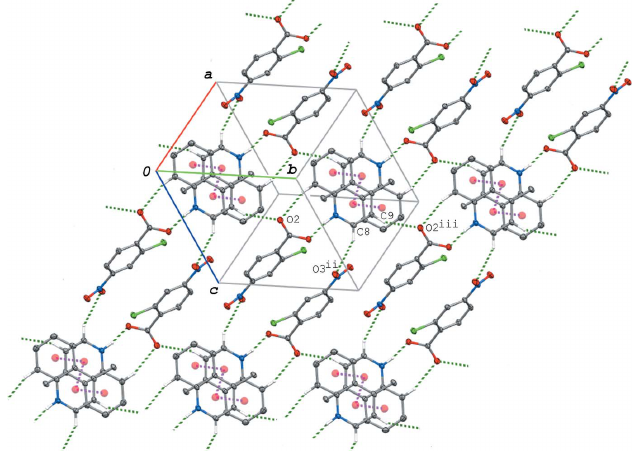
Figure 3 A packing diagram of (I), showing a layer structure parallel to (101) formed via the N—H (cid:2)(cid:2)(cid:2) O and C—H (cid:2)(cid:2)(cid:2) O hydrogen bonds (green dashed lines) and (cid:2) – (cid:2) interactions (magenta dashed lines). H atoms not involved in the hydrogen bonds are omitted for clarity. Cg 1 is the centroid of the C1–C6 ring. [Symmetry codes: (ii) (cid:3) x , (cid:3) y + 1, (cid:3) z + 2; (iii) x , y + 1, z .]